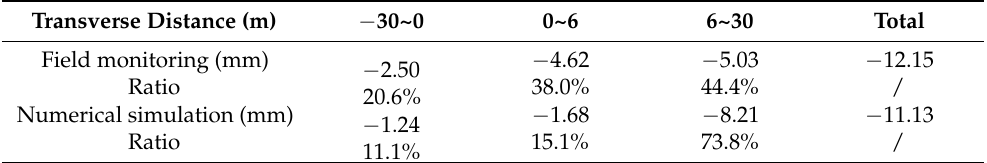
Table 7. The stratum settlement value at 3 m above the tunnel at different stages of shield tunneling in hole 3 #.